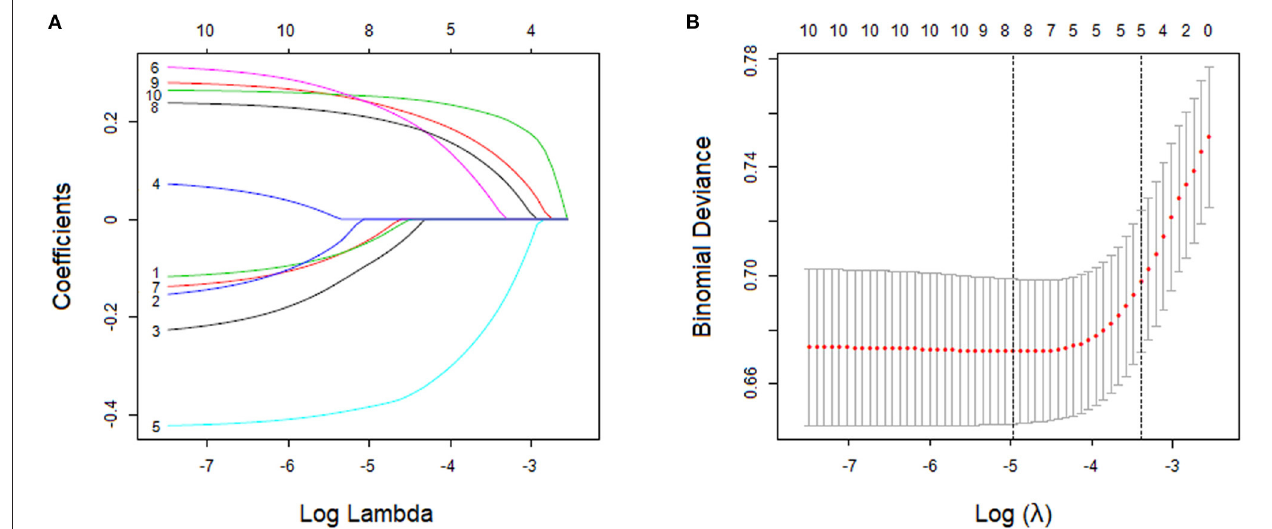
FIGURE 2 | Variable screening using the least absolute shrinkage and selection operator (LASSO) binary logistic regression model. (A) LASSO coefficient profile of features. This graph shows the relationship between the penalty coefficient log ( λ ) and the retained charicteristics. The number of intersecting curves represent the number of charicteristics retained at that log ( λ ) value. (B) The relationship between log ( λ ) and binomial deviance. Based on the 10-fold crossvalidation method, the relationship between log ( λ ) and binomial deviance is drawn. The dotted vertical lines were drawn at the optimal values by using the minimum criteria and the minimum criterion of 1